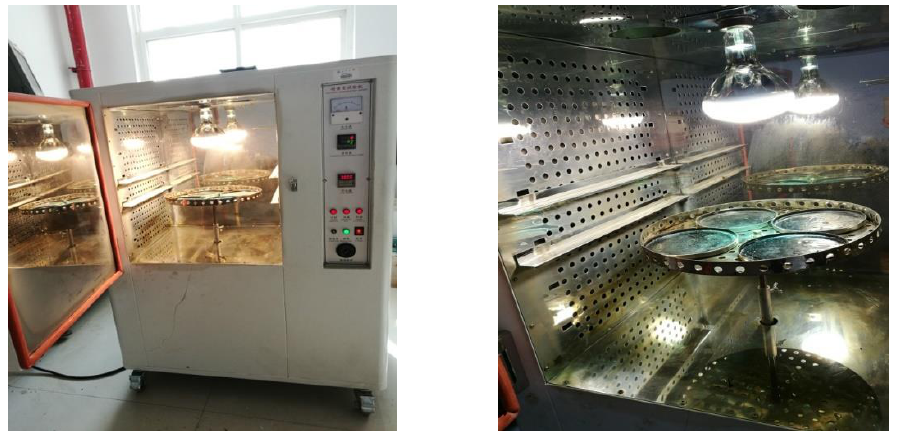
Figure 6. Antiyellowing aging box.